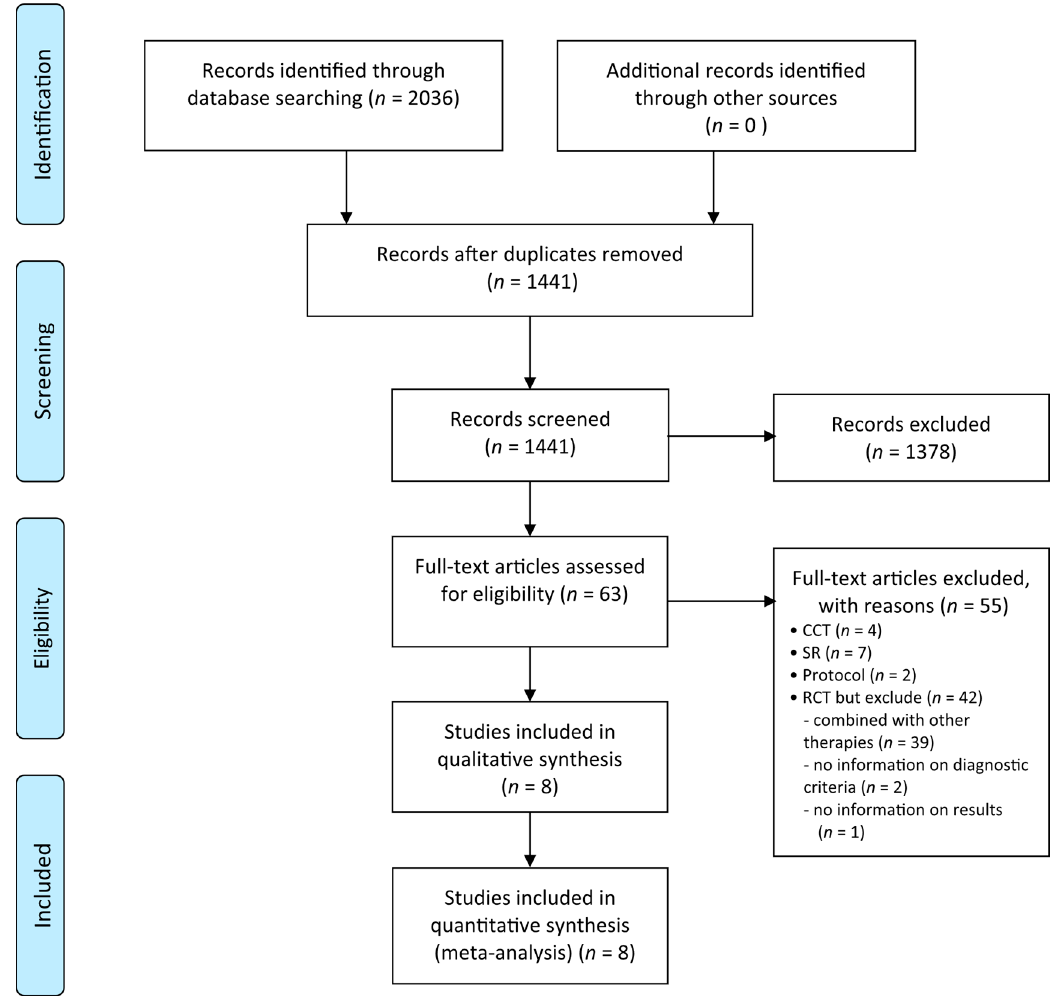
Figure 1. Flow chart. CCT: controlled clinical trials; RCT: randomized controlled trials; SR: systematic review.